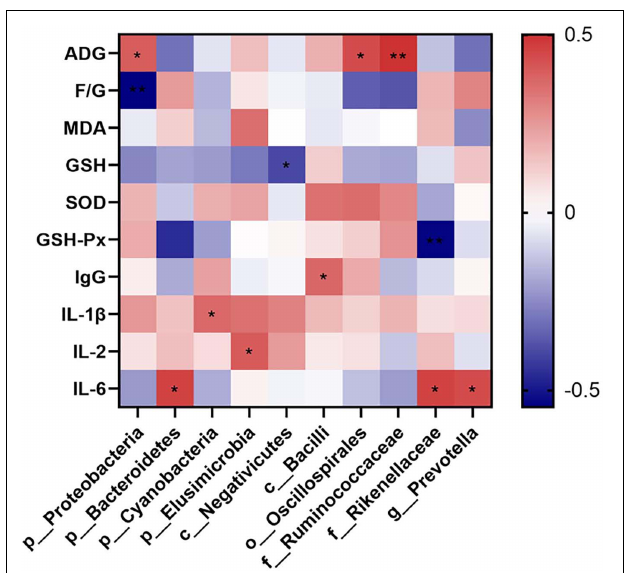
FIGURE 5 | Spearman correlation heatmap of cecal microbiota and the measured parameters. The intensity of the colors demonstrated the degree of association (blue, negative correlation; red, positive correlation). Significant correlations marked by *0.01 < P ≤ 0.05, **0.001 < P ≤ 0.01. ADG, average daily weight gain; F/G, ratio of feed intake to weight gain; MDA, malonaldehyde; GSH, glutathione; SOD, superoxide dismutase; GSH-Px, glutathione peroxidase; IgG, immunoglobulin G; IL-1 β , interlukin-1 β ; IL-6, interlukin-6; IL-2, interleukin-2.